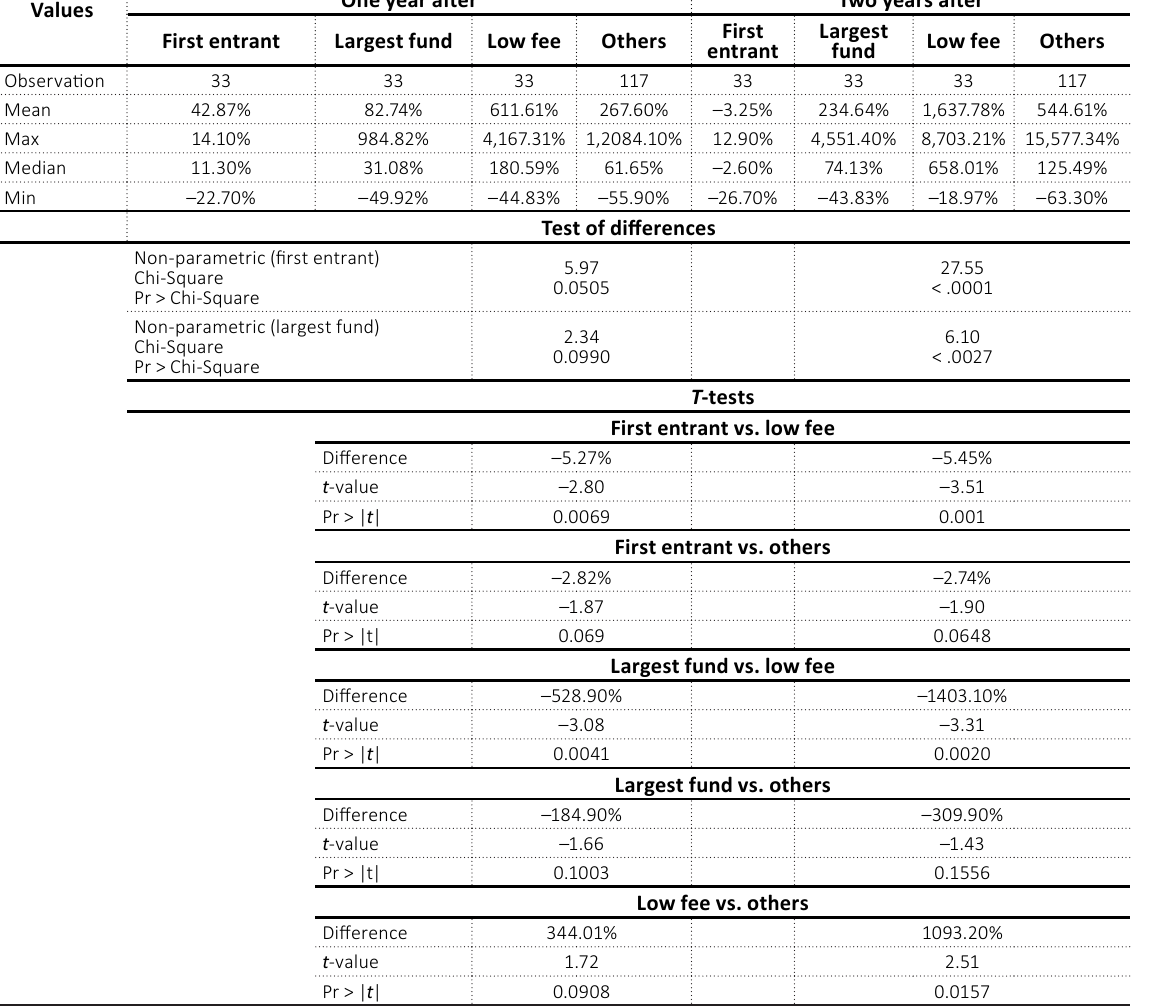
Table 6. Percentage of change in market share one and two years after the entrance of low fee ETFs